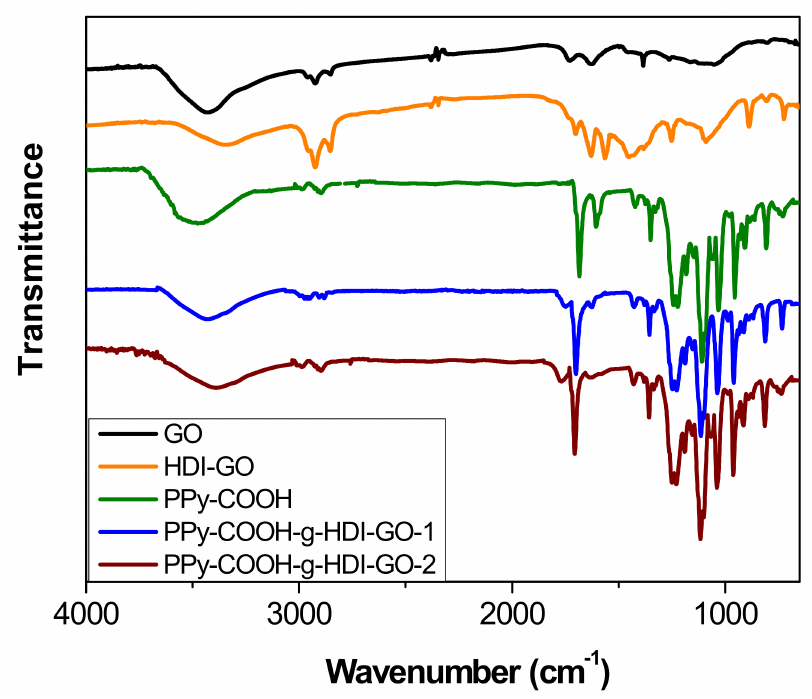
Figure 3. FT-IR spectra of neat GO, HDI-GO, PPy-COOH, and the two grafted